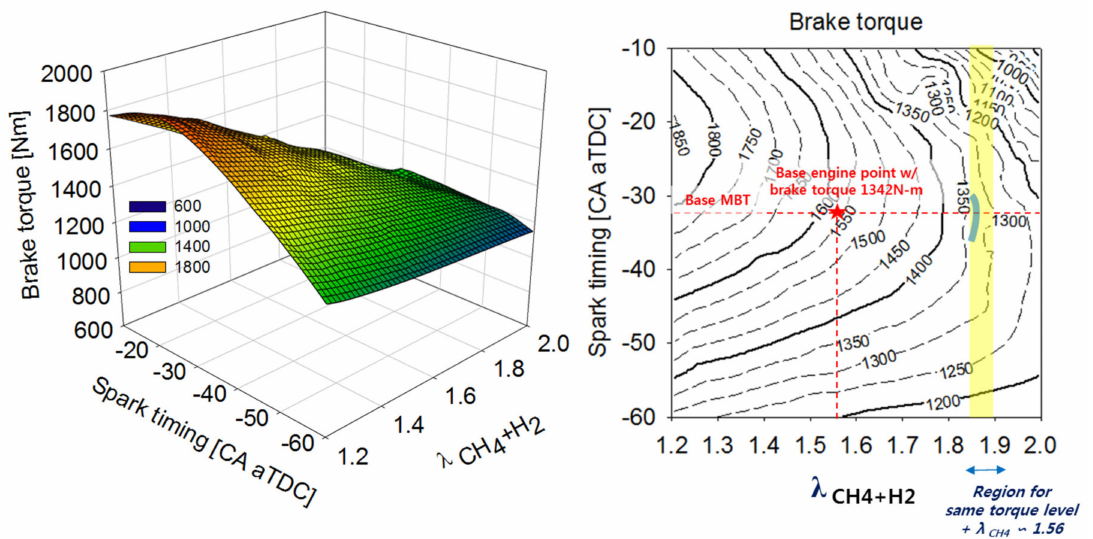
Figure 11. Response surface model: brake torque as functions of spark timing and hydrogen added methane based EAR @1500